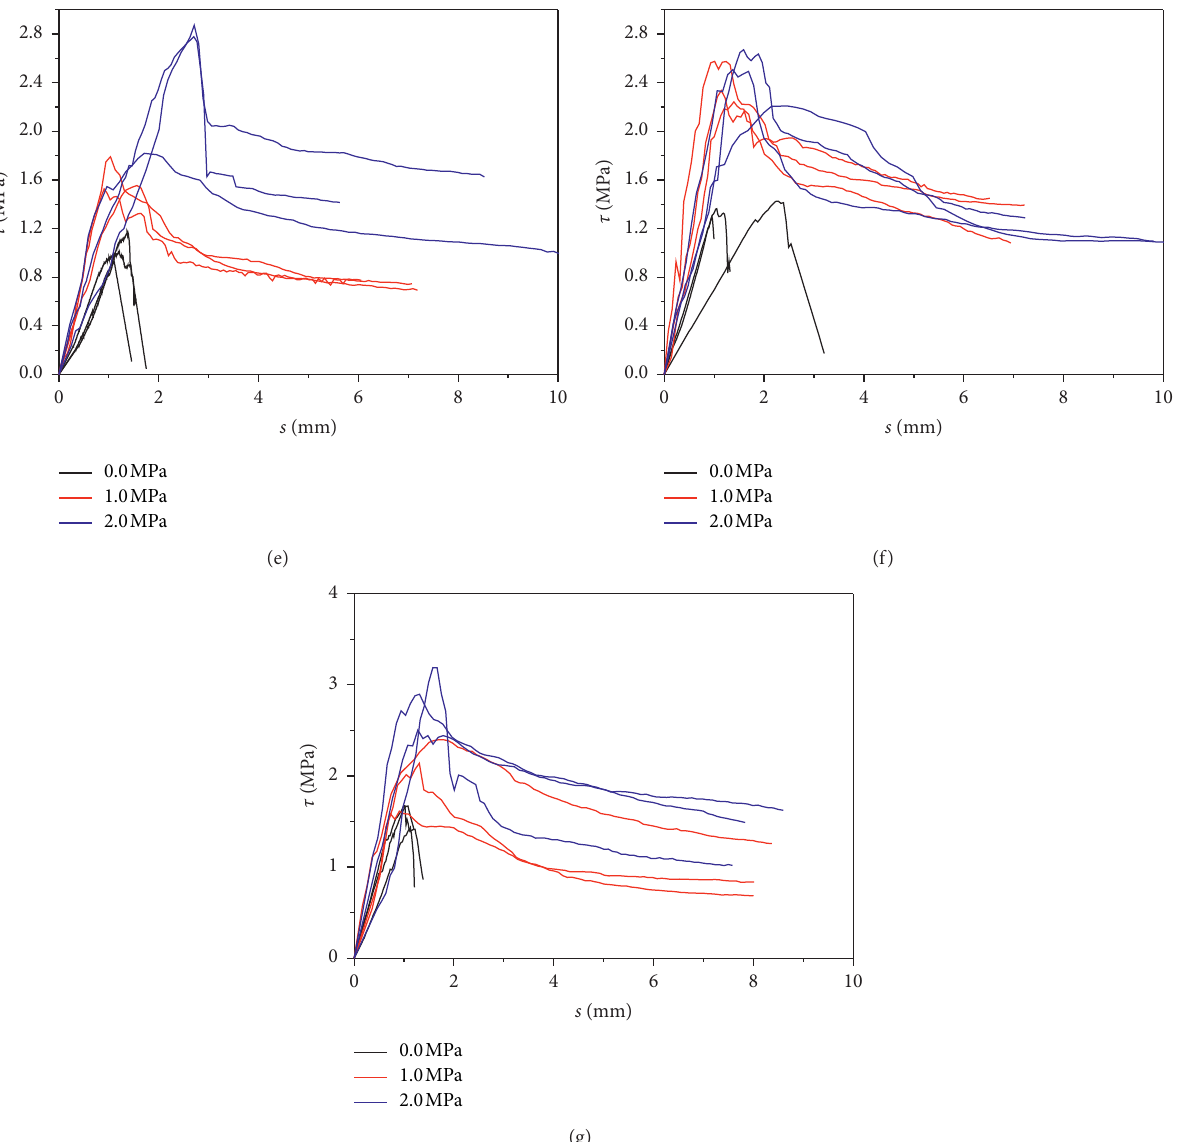
Figure 10: The load-slip curves of specimens with different normal pressure. (a) C40P23; (b) C40P23; (c) C40P36; (d) C40P43; (e) C40P54; (f) C40P69; (g)